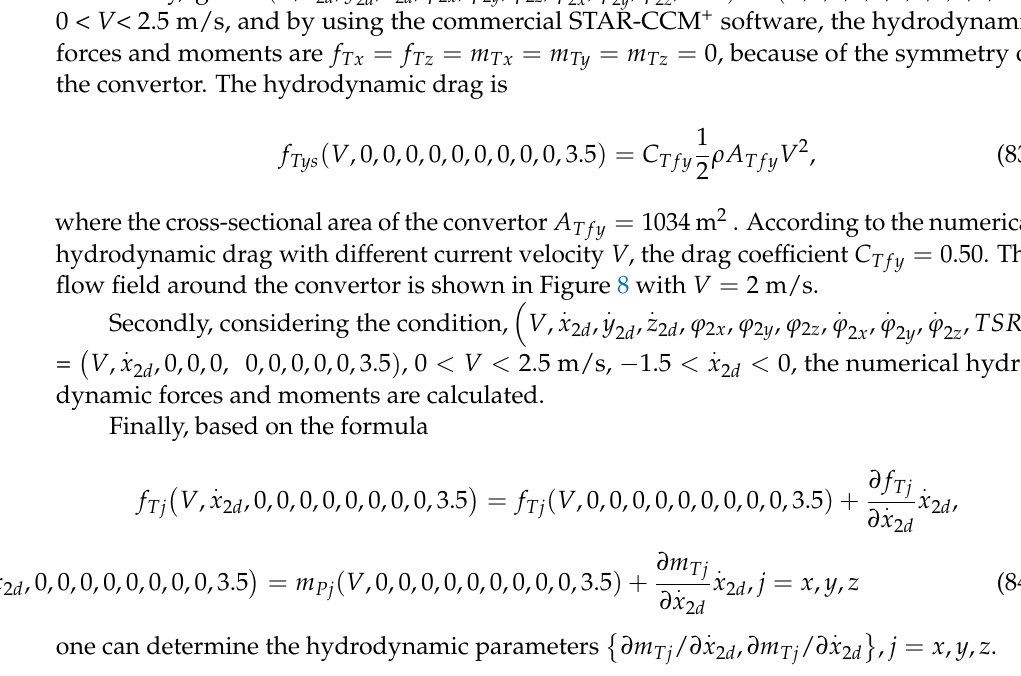
( b ) Blade section ( c ) Relationship between pitch angle and radius Figure 7. Configuration of turbine blade. The two turbine blades rotate reversely at the same rotating speed for rotational bal- ance. Under the current velocity V = 2 m/s, the velocity field around the fixed convertor with rotating blade at the tip speed ratio TSR = 3.5 is calculated by using Star CCM+ and shown in Figure 8. It is observed that the current flows through the turbine blade along the guide tunnel. It will increase the flow velocity through the blade and the power gen- eration. Moreover, the flow field around the two turbine blades will not disturbs each other. Figure 9 shows the effect of the TSR on the power coefficient of the turbine, CP = power/ 3 12 AV     , at the current velocity V = 2 m/s. The maximum power coefficient CP of the proposed turbine is 0.43 at TSR = 3.5. 